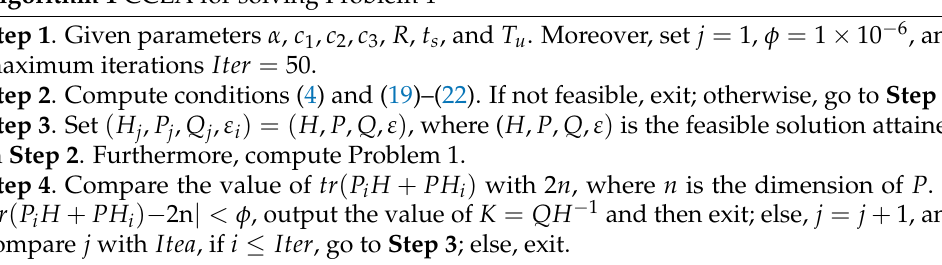
Algorithm 1 CCLA for solving Problem 1